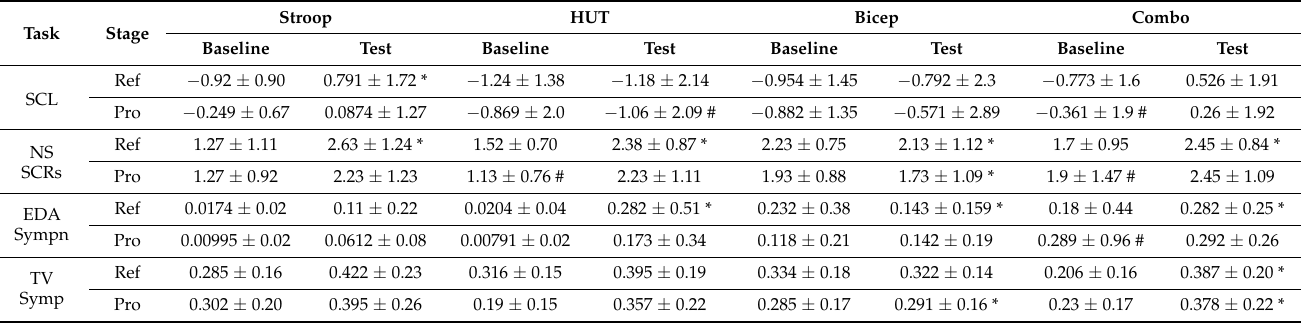
Table 2. Results for EDA Indicies.